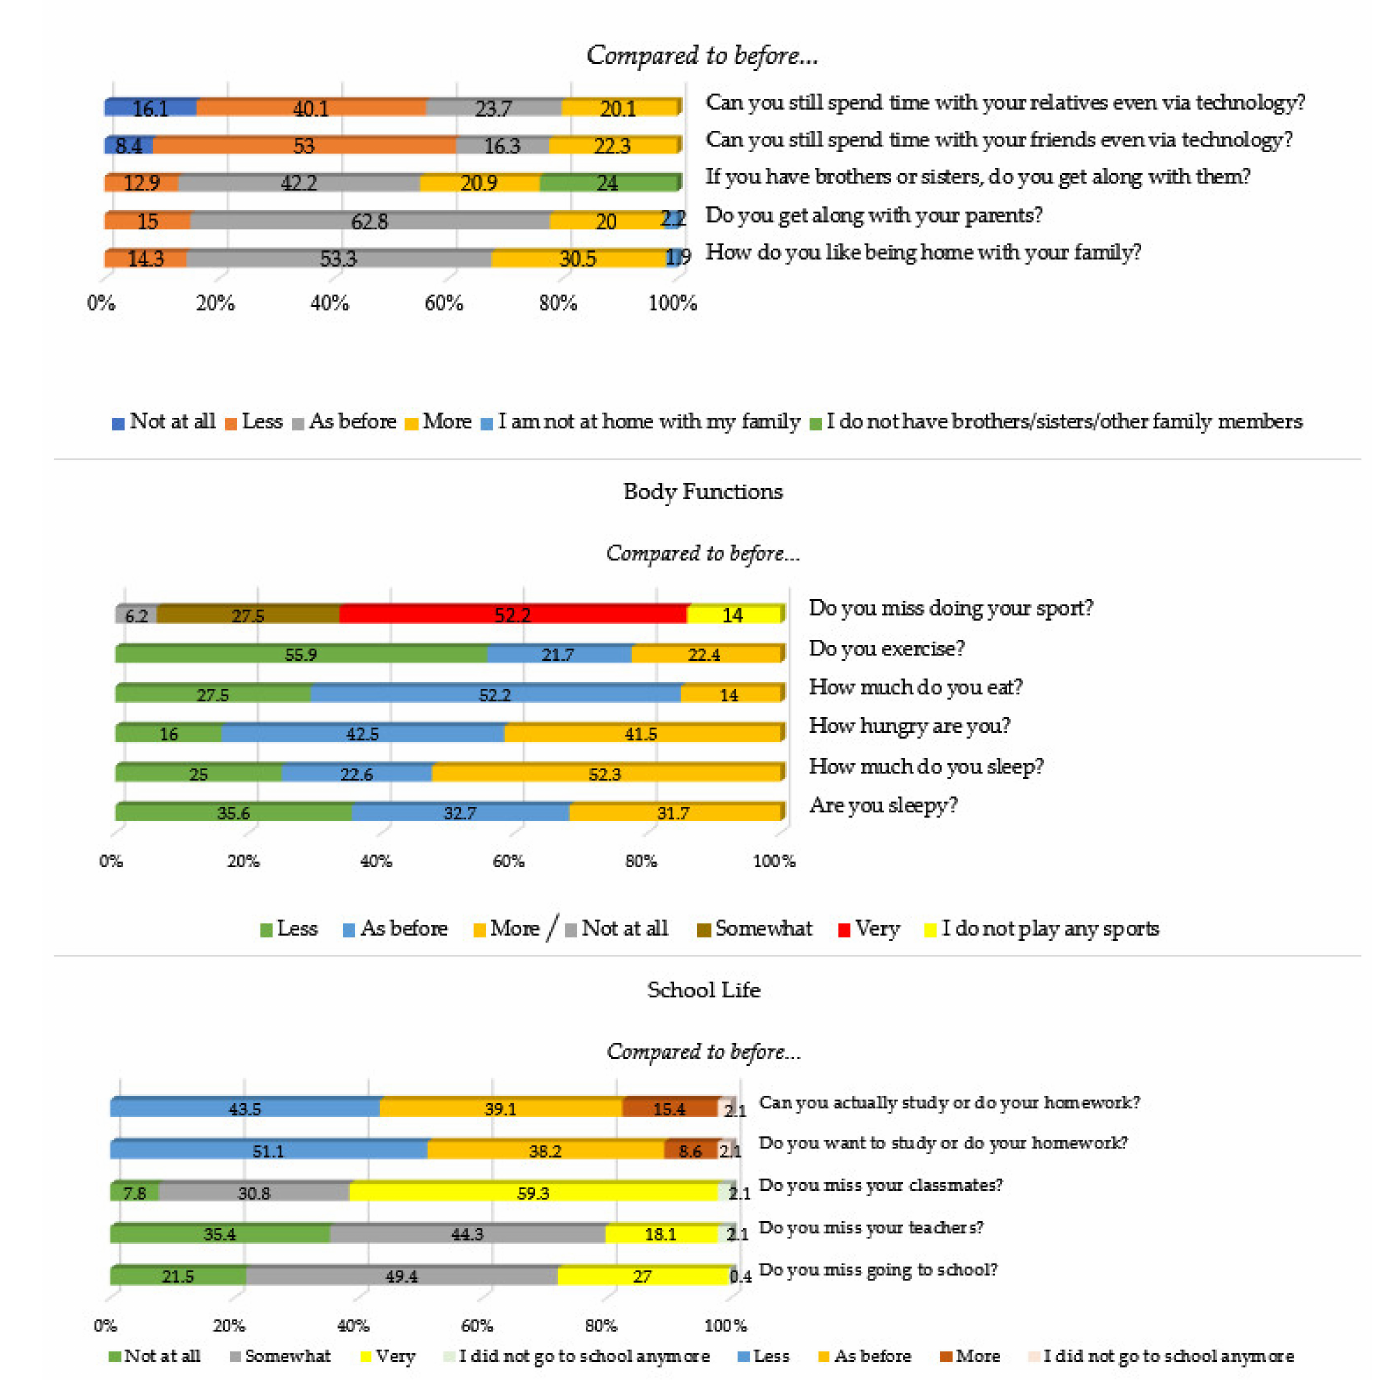
Figure 1. Frequency (%) of the investigated variables related to family life, important relationships, body functions, and school life ( N =